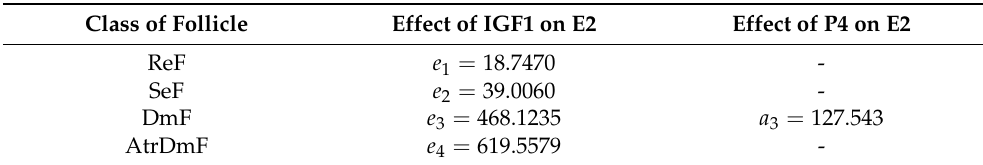
Table 3. E2 production by 1 mm 3 of granulosa cells in different classes of healthy and atretic follicles for Equation (1). These are unscaled